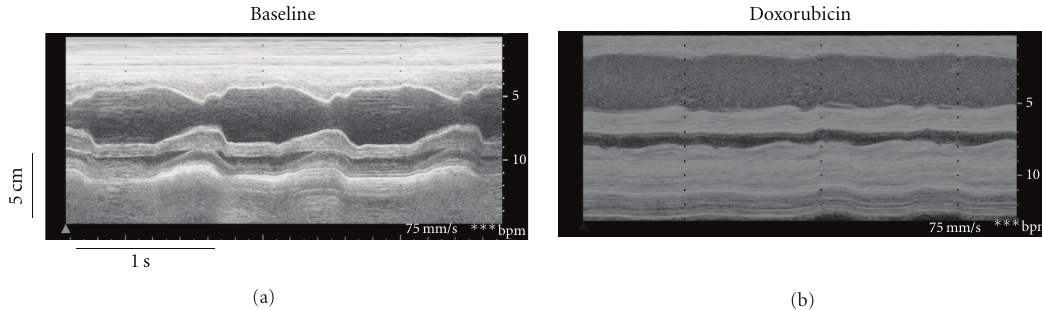
Figure 1: M-mode echocardiographic images from the same animal at baseline (a) and 60 days after initiation of weekly intravenous doxorubicin (b). Table 2: Serial echocardiography in doxorubicin-treated calves. Baseline Final awake Final anesthetized LVEDV (mL) 58 ± 2